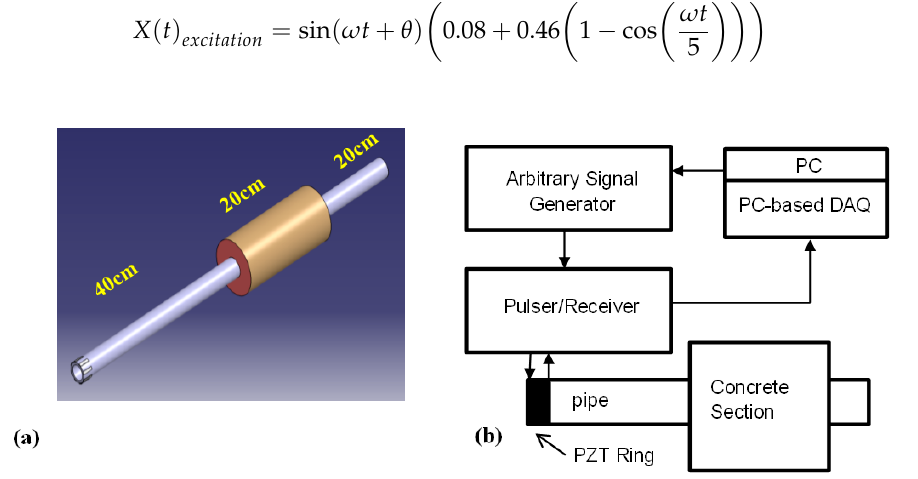
Figure 3. Concrete covered pipe ( a ); and schematic diagram of experimental setup; concrete covered pipe ( b ).